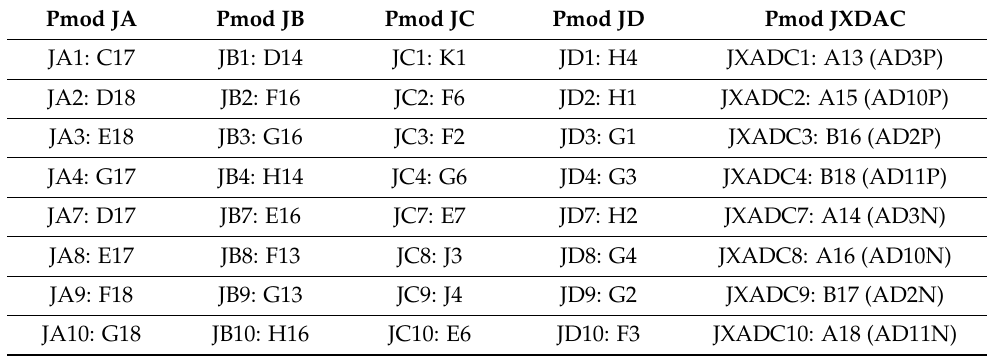
Figure 15. Constraint file example.